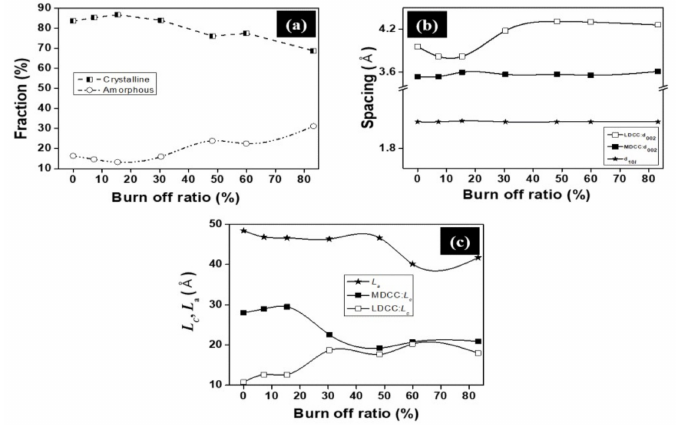
Figure 3. Changes in structural parameters of activated carbon blacks. ( a ) Changes in amorphous and crystalline fractions, ( b ) Changes in the interplanar distance, and ( c ) Changes in crystallite size ( L c , L a